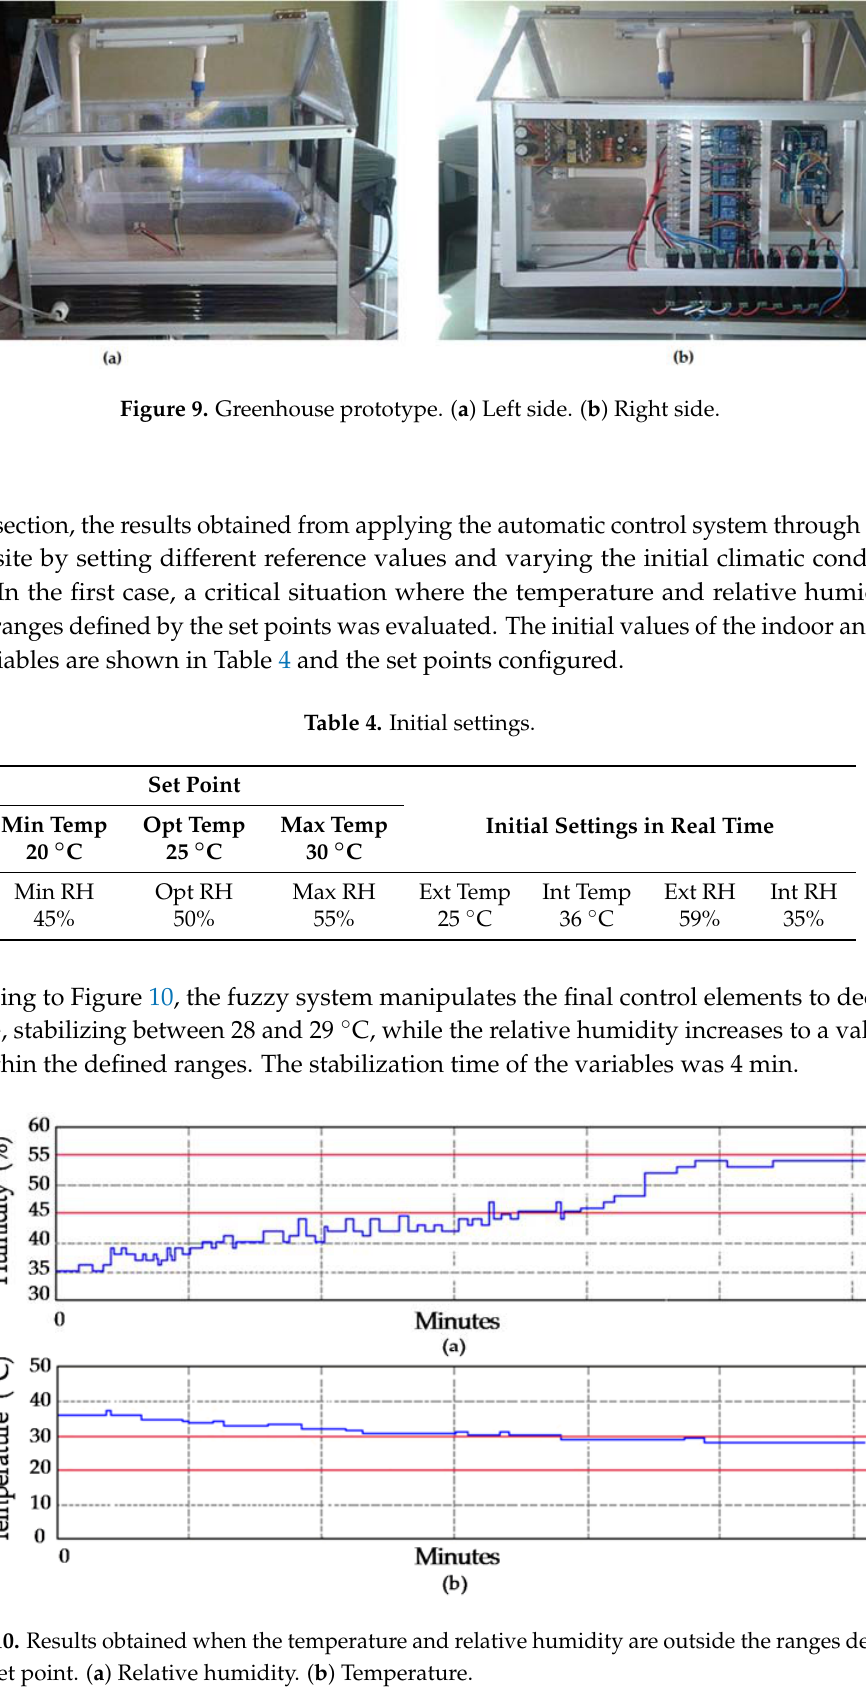
Figure 11. Results obtained when the relative humidity is above the set point and the temperature is in the defined range. ( a ) Relative humidity. ( b ) Temperature. Figure 12. Soil moisture for Irrigation 9.